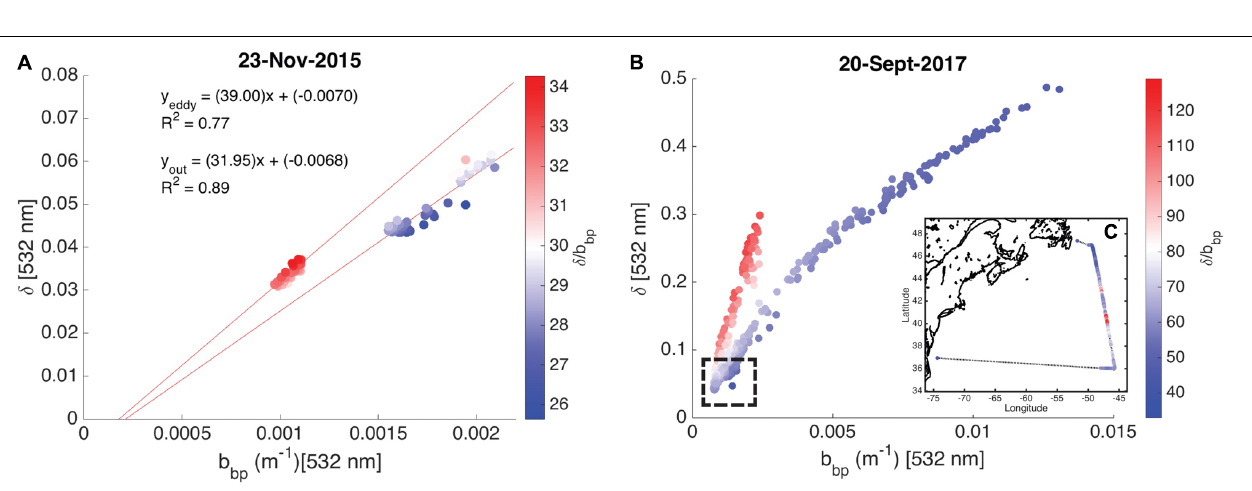
FIGURE 7 | Scatter plots showing the relationship between the particulate backscattering coefficient ( b bp , m − 1 ) and the depolarization ratio ( δ , unitless) shown as a function of the ratio, δ / b bp . (A) Measurements collected on November 23, 2015 (data presented in this study) are shown. The linear models for data collected inside and outside the eddy are presented with R 2 values. (B) Measurements collected on September 20, 2017 are shown. No in situ data are available for this flight. The hashed box shows the dynamic range of data presented in this study. (C) The inset shows δ / b bp along the entire September 20, 2017 flight line.